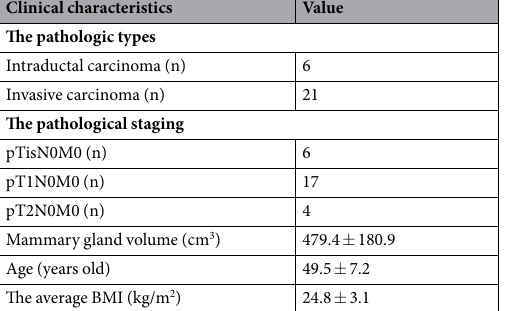
Table 4. Characteristics of the study population (n = 27). BMI: body mass